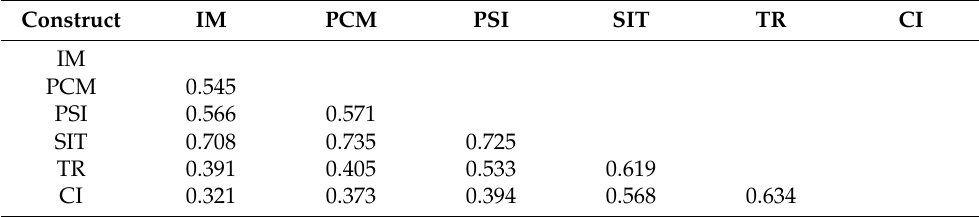
Table 5. HTMT matrix.